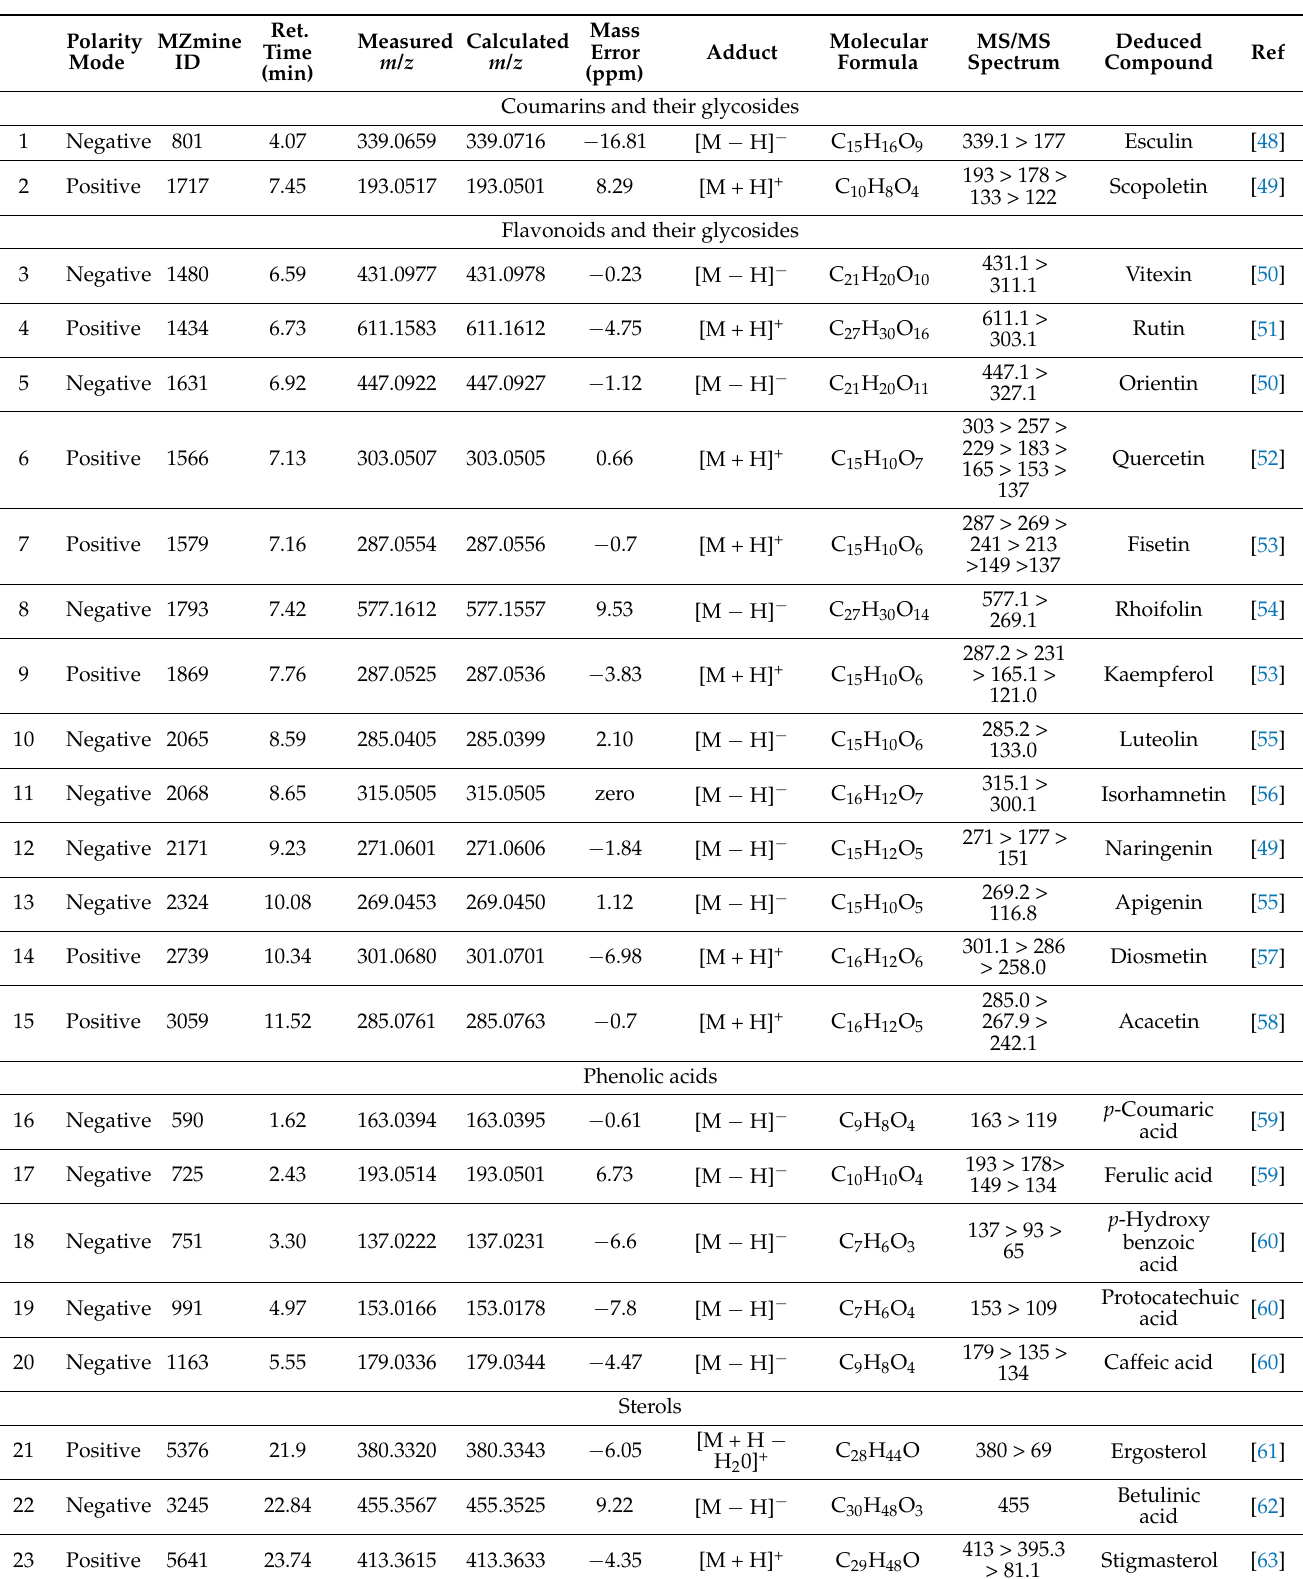
Table 3. LC-MS/MS metabolomic analysis of the ethanolic crude extract of A. judaica